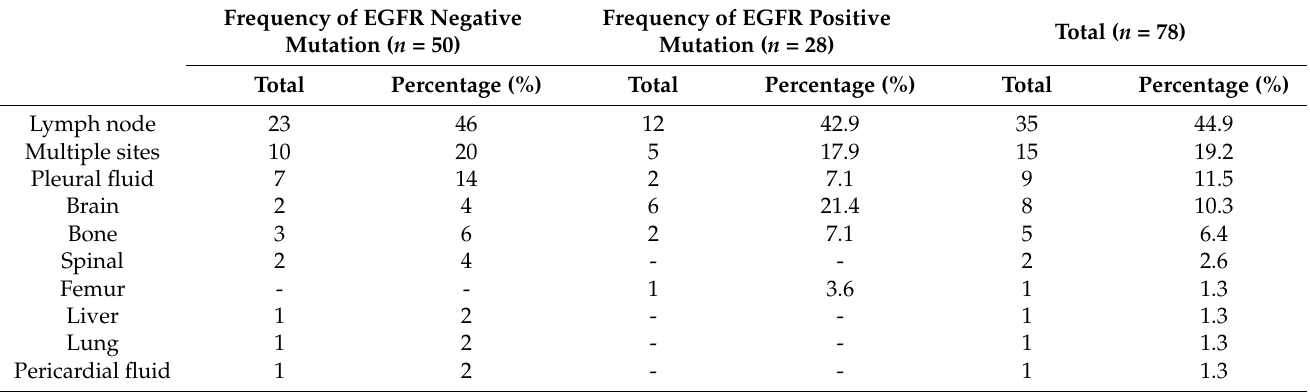
Table 4. Classification of metastatic samples based on EGFR mutation status and location of metastasis (F—Frequency;